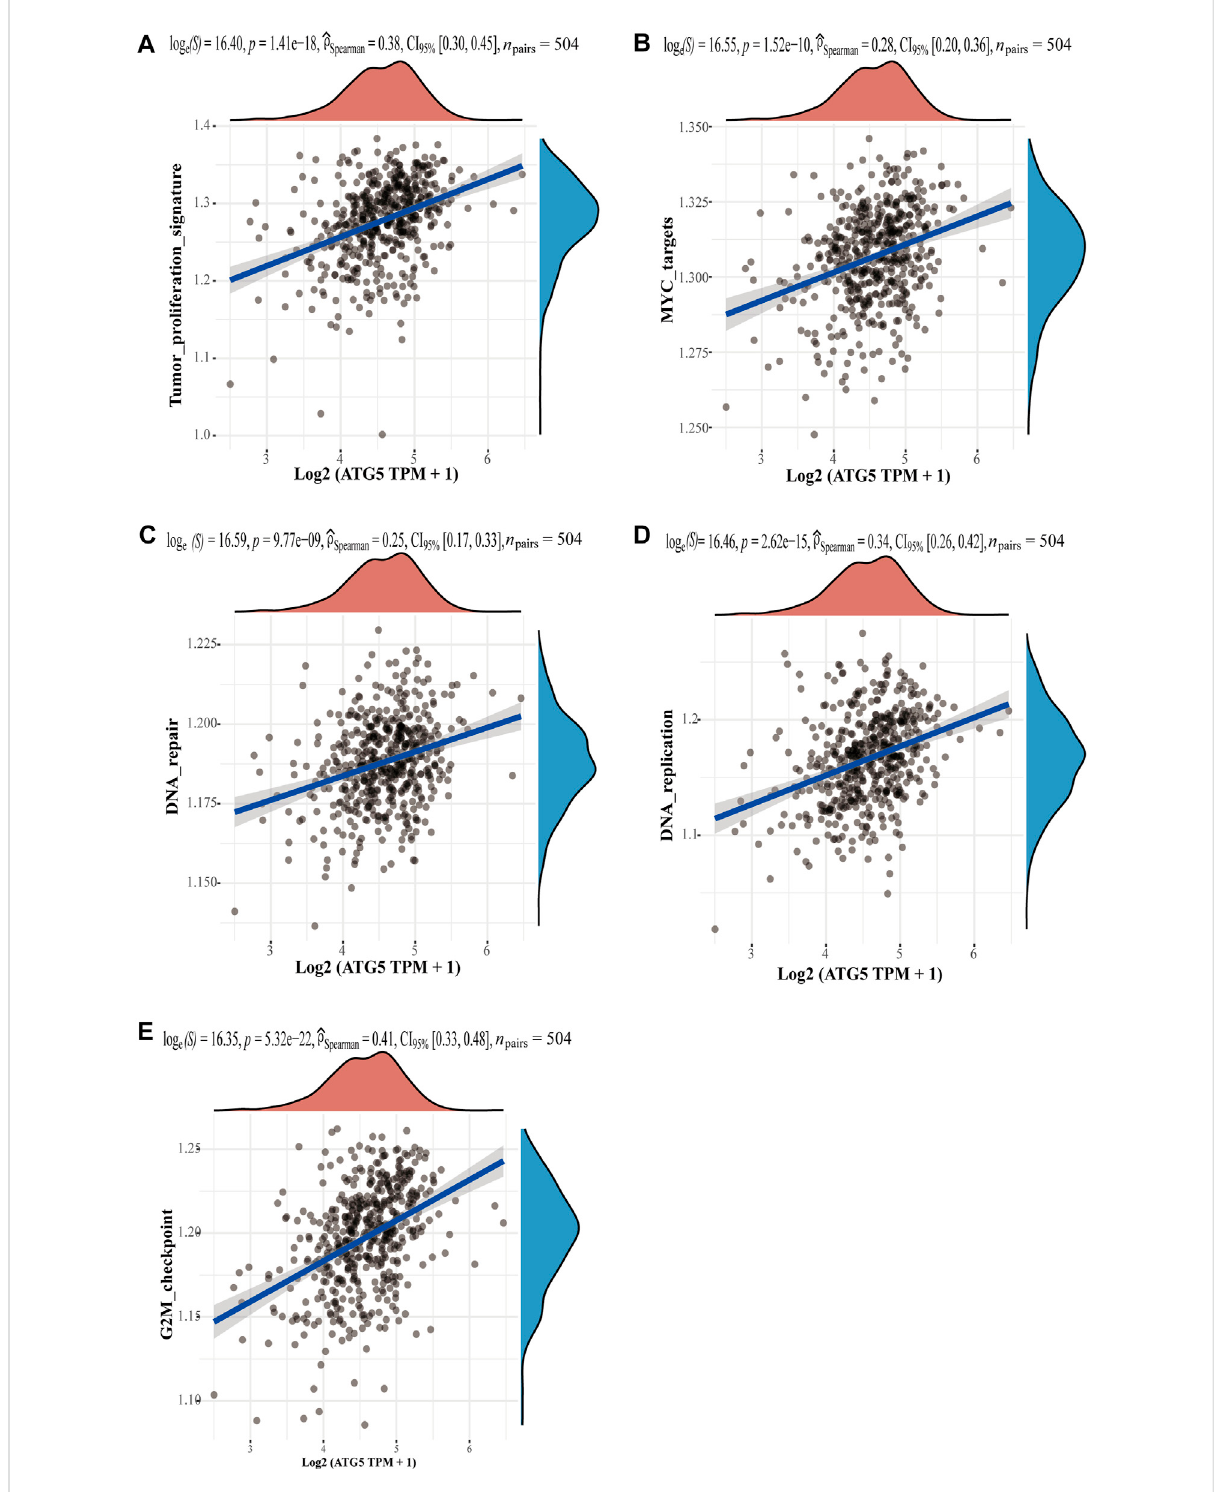
FIGURE 6 The correlations between ATG5 and pathways. (A) Tumor proliferation signatures, (B) MYC targets, (C) DNA repair, (D) DNA replication, and (E) G2M checkpoint. The abscissa represents the distribution of the gene expression, and the ordinate represents the distribution of the pathway